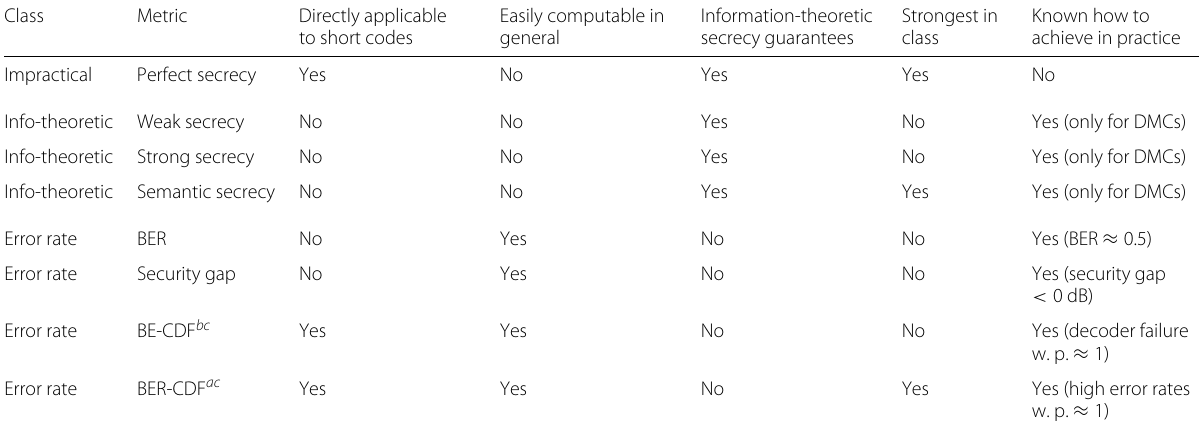
Table 1 Summary of current physical-layer security metrics, highlighting some of their pros and cons